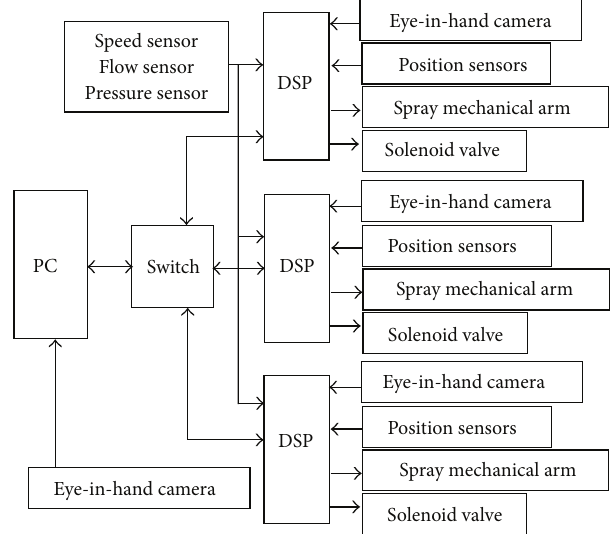
Figure 3: Visual processing and servo control system.